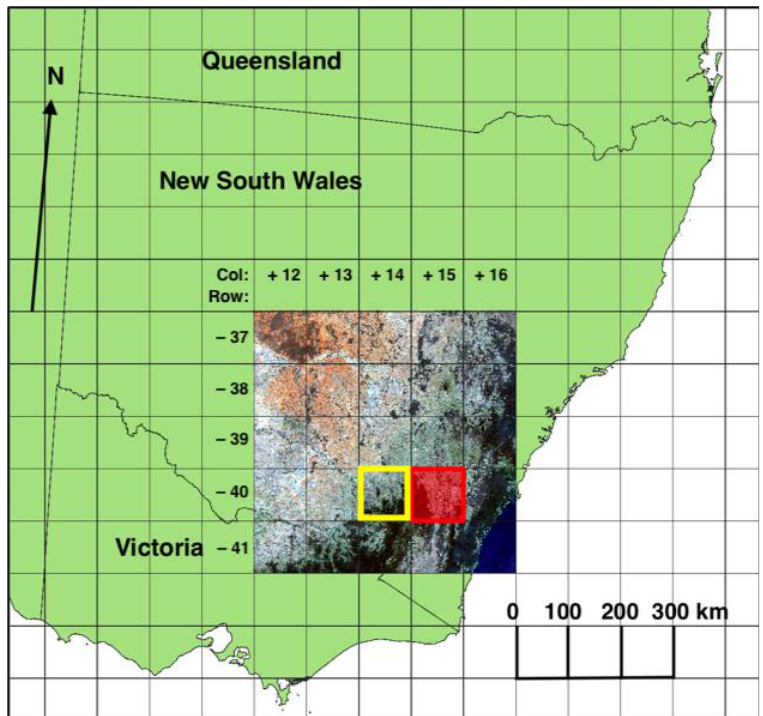
Figure 1. Study area (2018 Landsat 8 geomedian true colour RGB), test tile +14, −40 (yellow box). Canberra tile +15, −40 (red box) used for application of U-Net CNN model for the period 1987–2020. Projection: GDA94/Australian Albers (EPSG:3577).